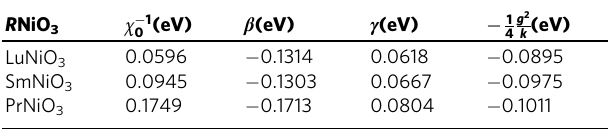
Table 1 Parameters that characterize the electronic and total energy of the three R NiO 3 materials, as extracted by fi tting the data from ref. 6 to Eq.